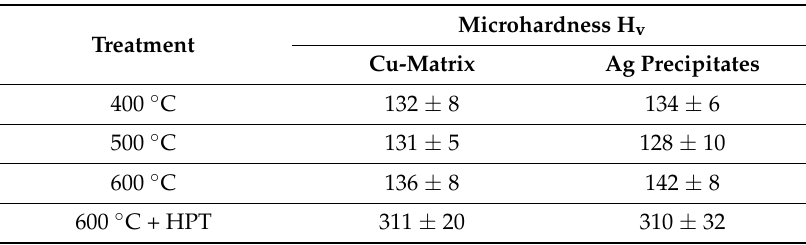
Table 3. Microhardness of Cu-matrix and coarse Ag precipitates in the Cu–8wt.%Ag alloy before and after HPT process.